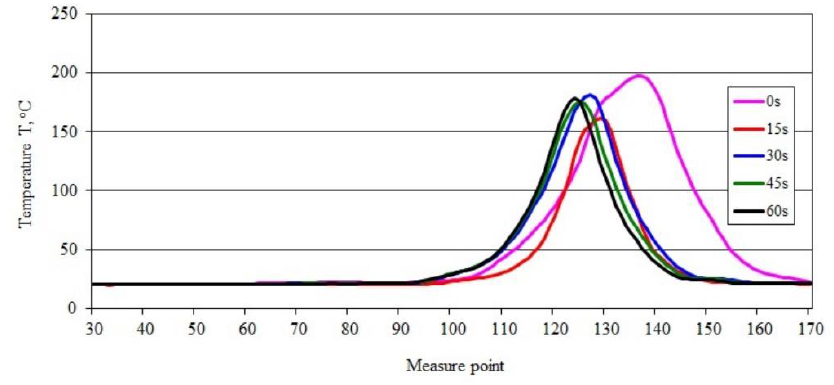
Figure 6. Temperature along the burning PBS sample recorded in area 2.